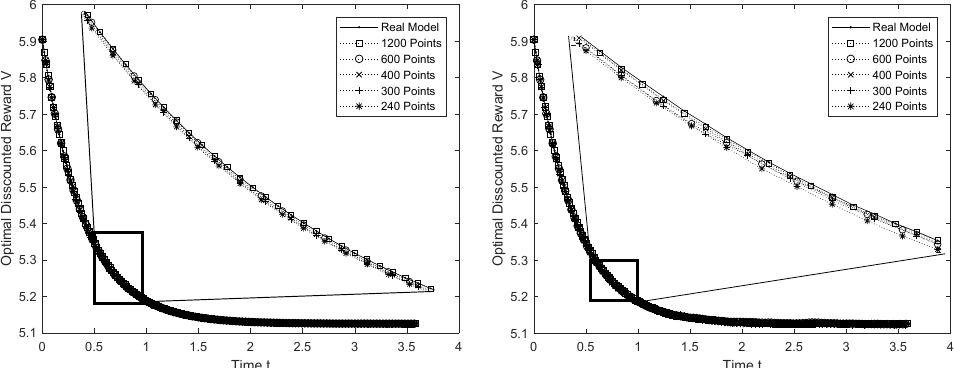
Figure 2. Asymptotic behavior of the optimal discount cost for σ = 0.0001 ( left ) and σ = 0.0007 ( right ). The diffusion process (27) with σ = 0.0001 showed the best fit because, with 1200 data, = 2.499682 and its RMSE is 9.76504 × 10 − 5 , which suggests that the lower the noise θ LSE m in the measured data, the more accurate the least square